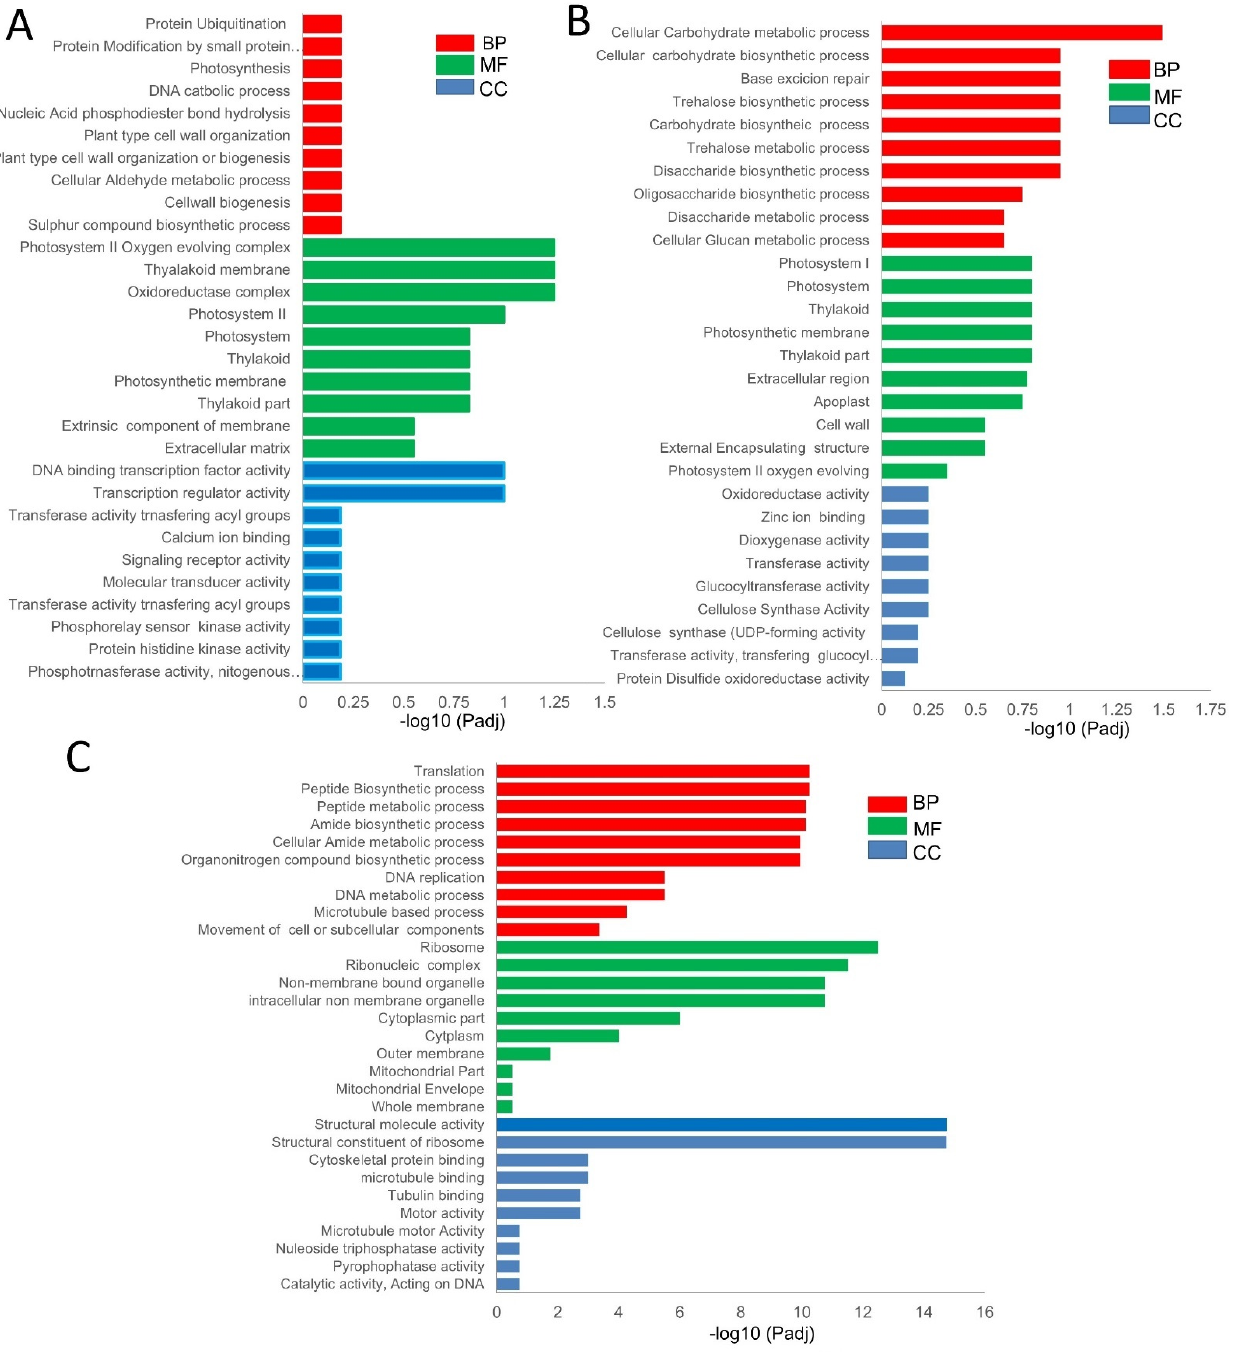
Figure 3. Gene ontology (GO) enrichment of differentially expressed genes in timepoint pairwise comparisons. ( A ) Shared GO in the pairwise comparisons between XS_vs_XN of 160 DEGs. ( B ) Common shared GO among timepoint pairwise comparisons of 30 DEGs within XN. ( C ) Common shared GO among timepoint pairwise comparisons of 1351 DEGs within XS. Red, green, and blue bars represent biological processes, molecular functions, and cellular components. The y -axis represents different GO terms and log10 (adj) in the x-axis.